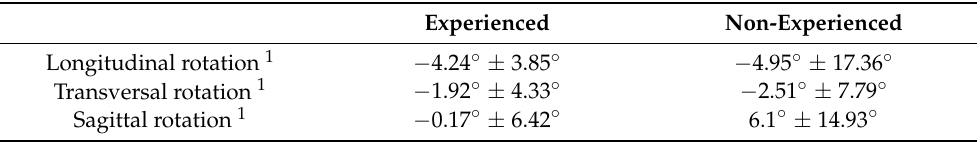
Table 2. Difference in angular orientation between the initial and retracted defensive position cross